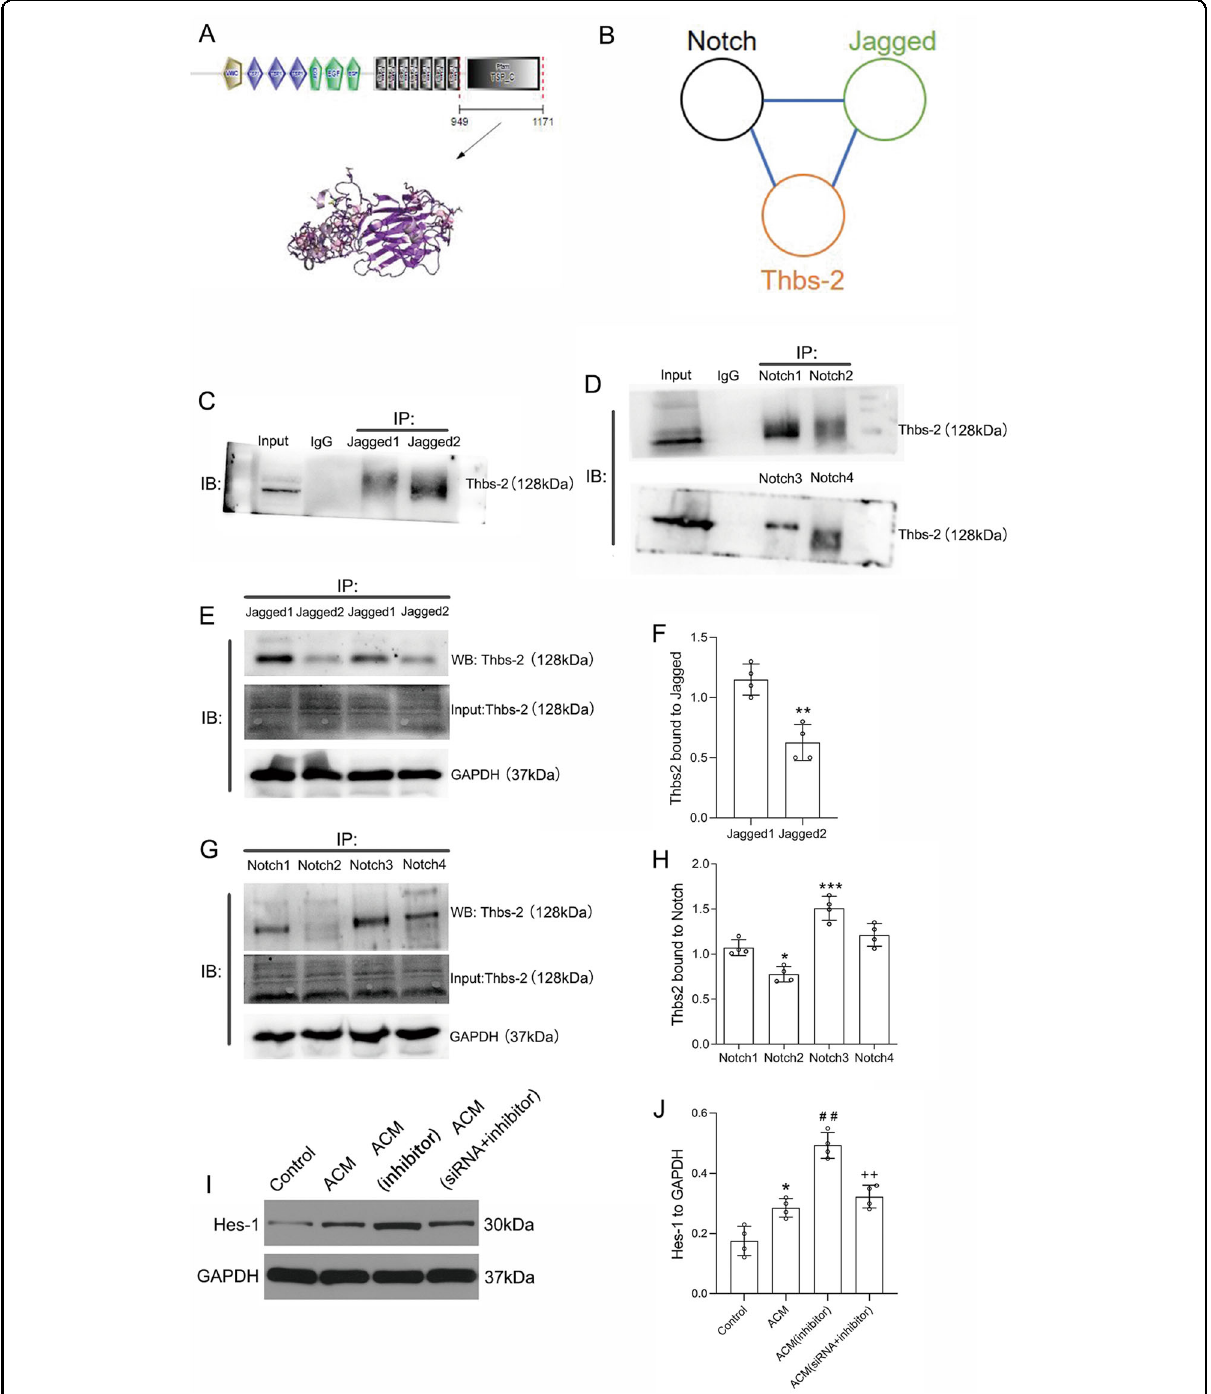
Fig. 5 Downregulation of miRNA-9-5p activated the Notch pathway by promoting the expression of Thbs-2. A The structure of Thbs-2 protein. B Schematic diagram of the relationship among Thbs-2, Notch, and Jagged. C Immunoblotting showing the relationship between Thbs-2 and Jagged. D Immunoblotting showing the relationship between Thbs-2 and Notch. E The immunoblotting and F quantitative data of Thbs-2 bound to Jagged1 and Jagged2 ( n = 4/group) (* P < 0.05, ** P < 0.01 versus the Jagged1 group). G The immunoblotting and H quantitative data of Thbs-2 bound to Notch1, Notch2, Notch3, and Notch4 ( n = 4/group) (* P < 0.05, ** P < 0.01, *** P < 0.001 versus the Notch1 group). I The immunoblotting and J quantitative data of Hes-1 in neurons ( n = 4/group) (* P < 0.05 versus the control group; ## P < 0.01 versus the ACM group; ++ P < 0.01 versus the ACM (inhibitor) group) (ACM: astrocyte co-cultured model). Error bars indicate mean ±